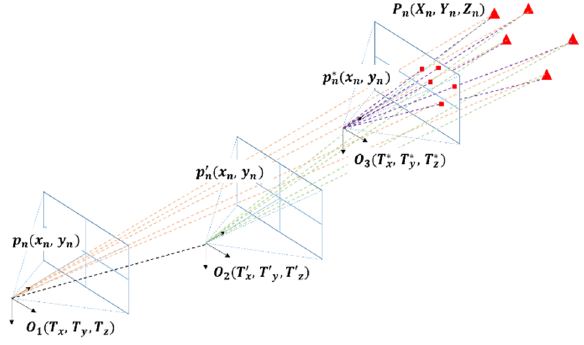
Figure 4. Absolute orientation in MMS geometry